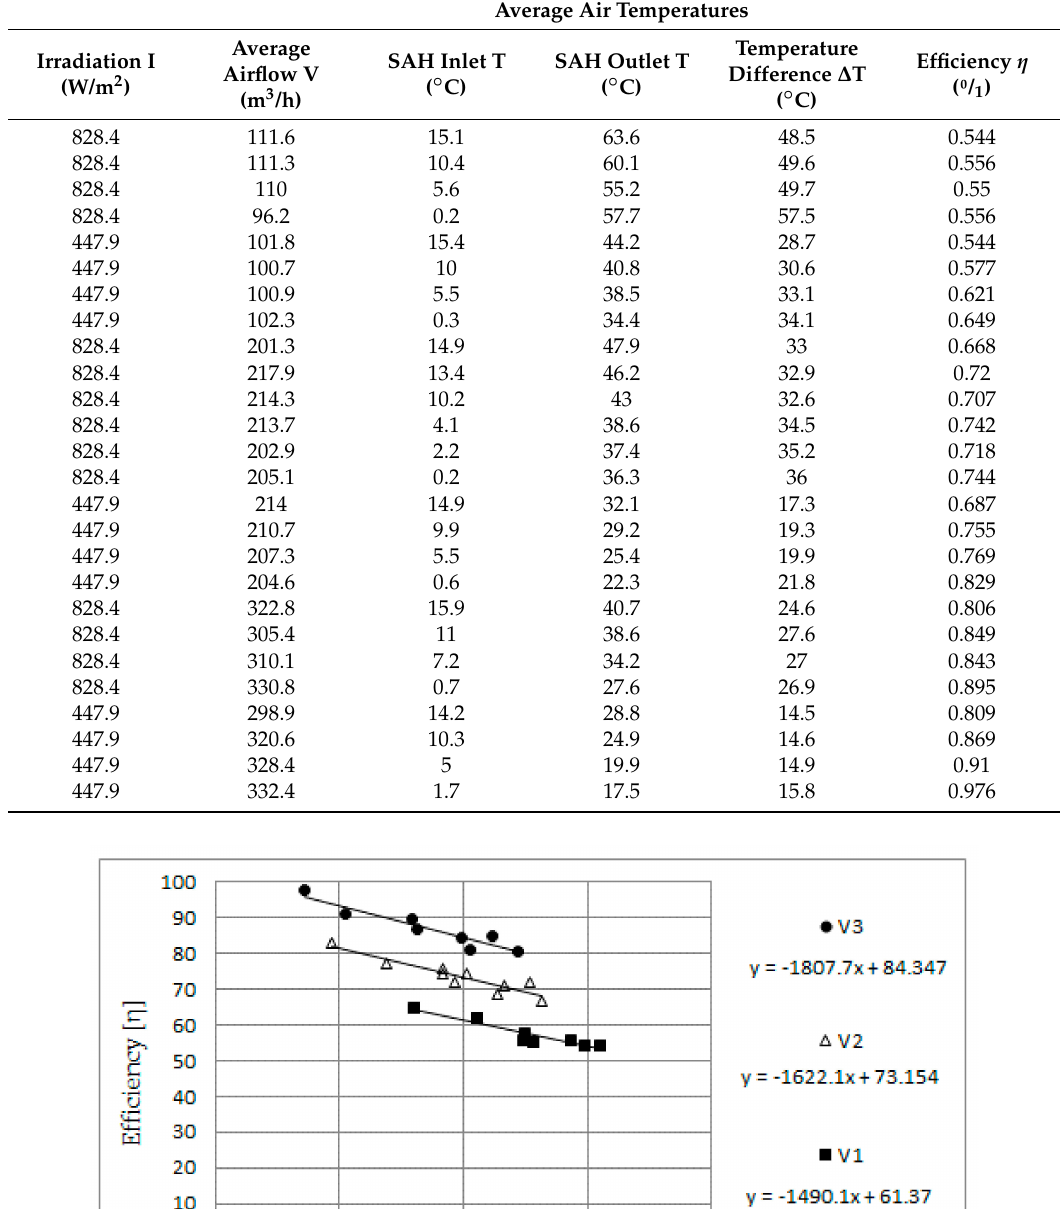
Table 2. Experimental results of the SAHs.